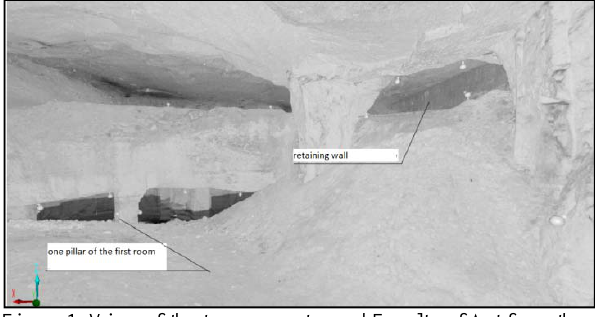
Figure 1. View of the two rooms toward Faculty of Art from the atrium (image produced by the laser scanner) Turning left from the hallway one arrives to the wide cavity,